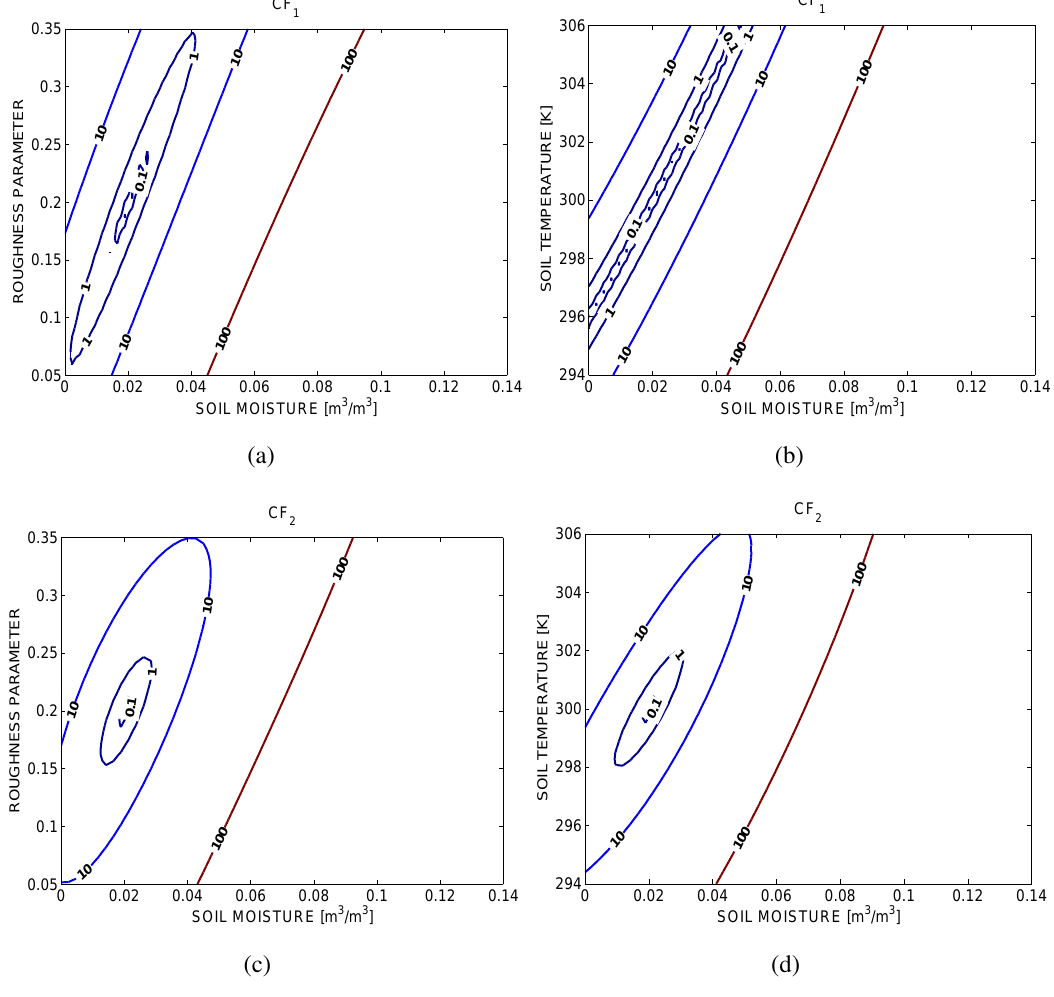
over a bare dry soil scenario. I (a) and T vs s (b), with no constraints on the cost m s m ). Contours of HR vs s (c) and T vs s (d), adding constraints 1 m s m ( CF m 2